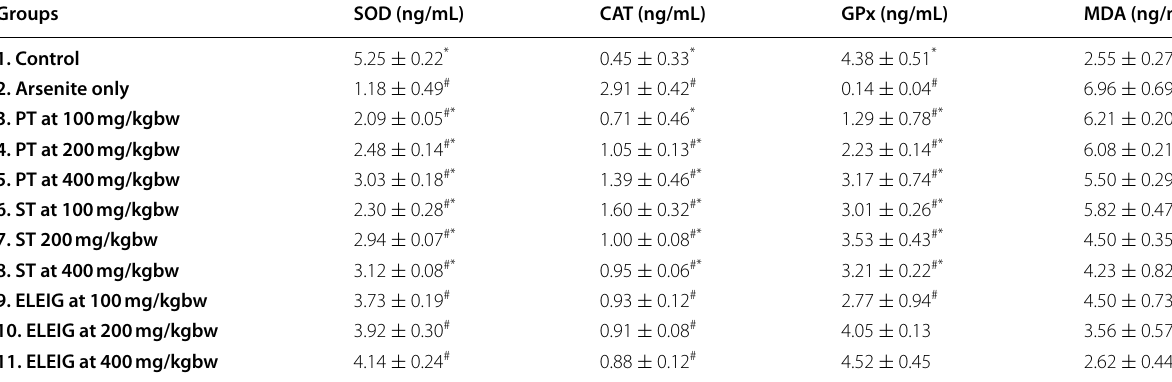
Table 3 Effect of ELEIG on oxidative stress biomarkers of experimental rats Groups